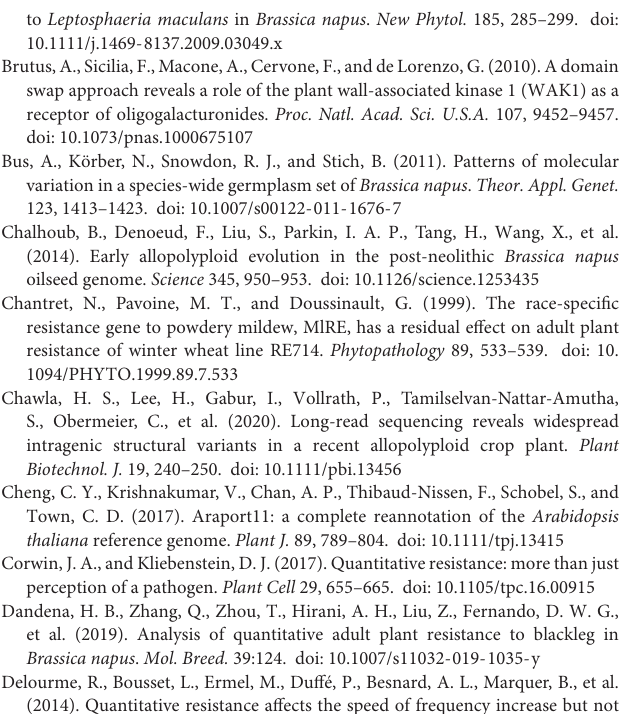
Supplementary Figure 1 | Phenotypic distribution of VDT values from greenhouse screenings for the entire mapping population (A) and the